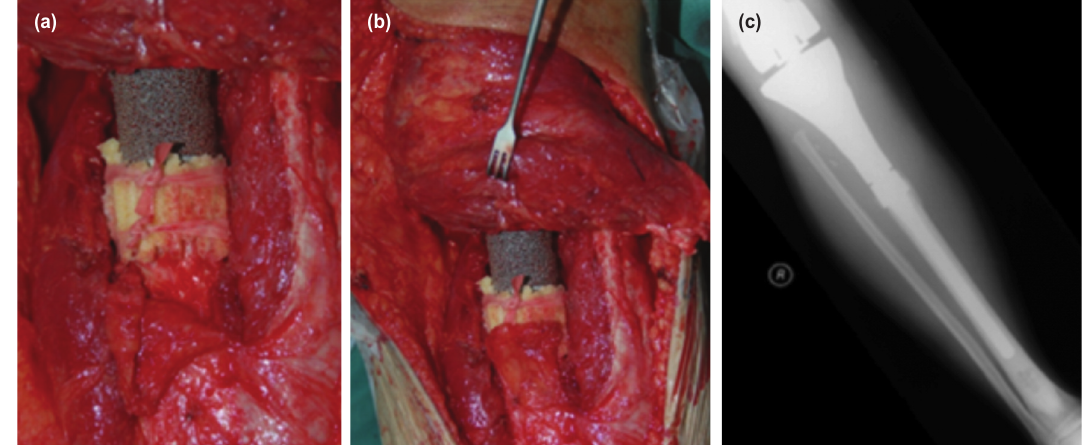
(a,b,c) Giant cell tumour of proximal tibia with EBBI and periosteal flap at 2 years, patient was follow-up with no loosening of Fig. 2: implant at 14 years after surgery.